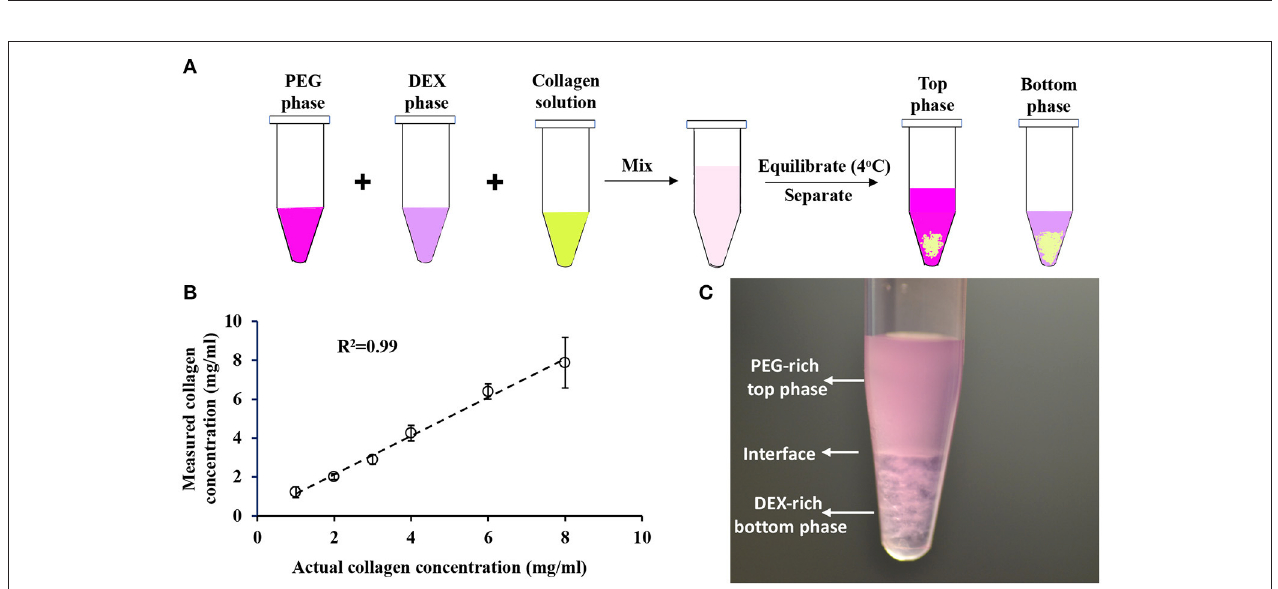
FIGURE 2 | (A) Schematic of collagen partition experiment in ATPS. (B) Quantification of collagen concentration using hydroxyproline assay. Error bars represent standard deviations. (C) Collagen partition assay containing equal volumes of 15% PEG35k, 21% DEX500k, and 2 mg/ml collagen results in formation of 5% PEG-7% DEX